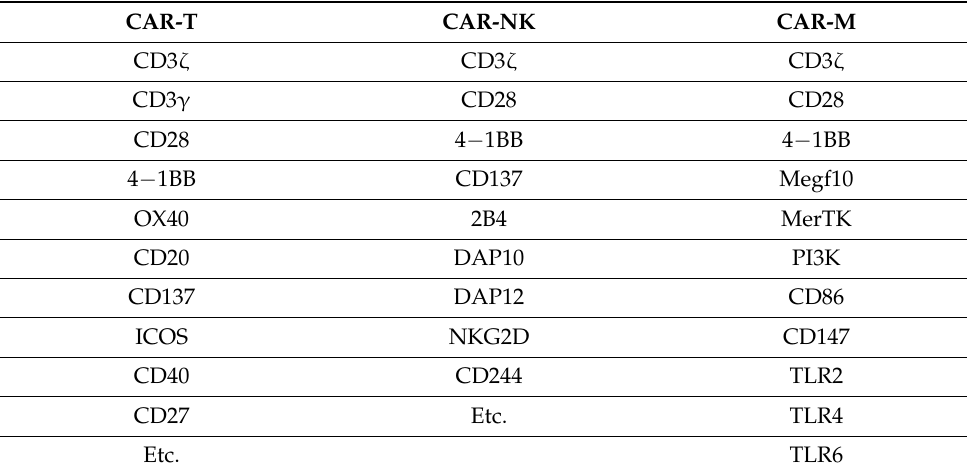
Table 1. CAR-T, CAR-NK and CAR-M signalling domains. Main domains applied in CAR constructions.